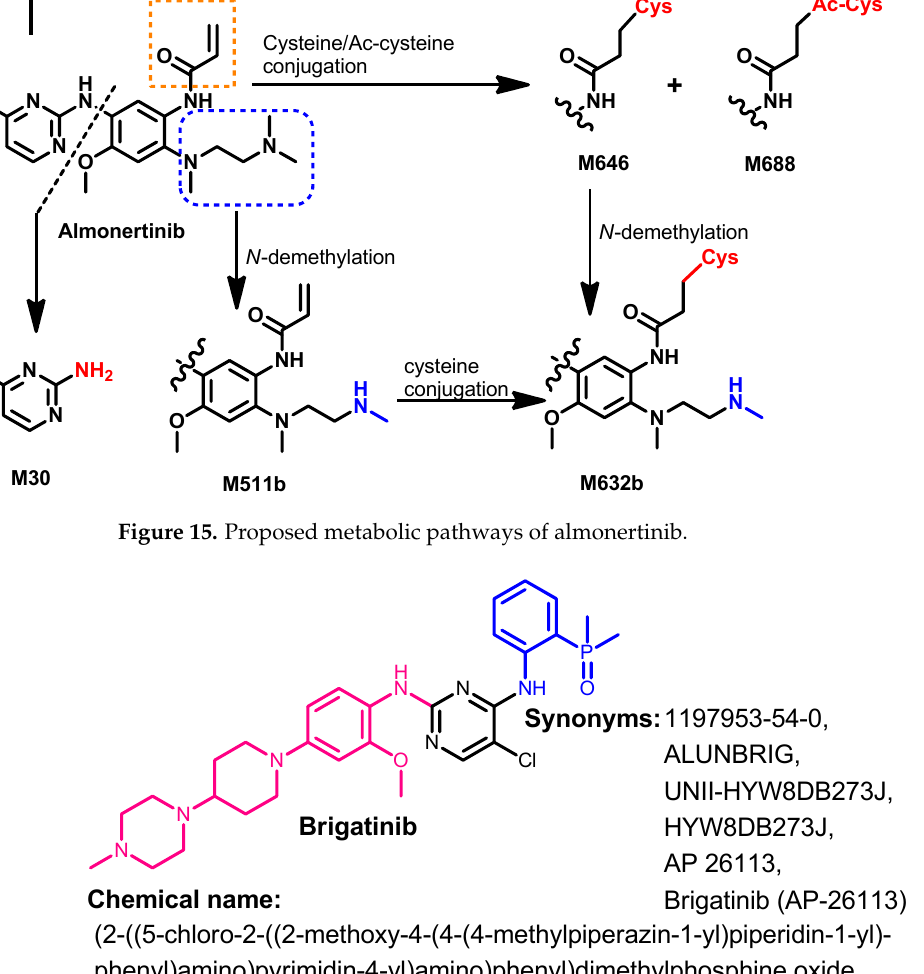
Figure 15. Proposed metabolic pathways of almonertinib.